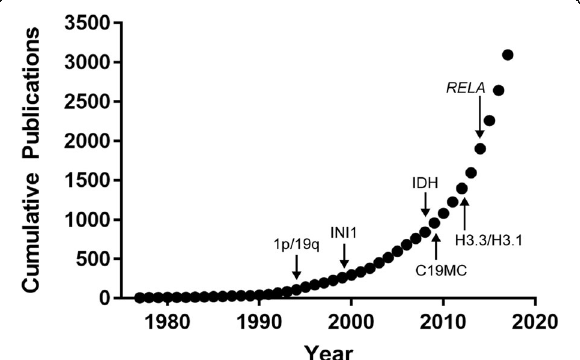
Fig. 1 Exponential growth in brain tumor molecular information. Pubmed search results for the combined terms “ brain tumor ” and “ molecular ” from 1979 to 2017. Annotations show the year of identification for key molecular features that were incorporated into the WHO 2016 diagnostic recommendations, including 1p/19q- codeletion for oligodendroglioma (1p/19q), loss of INI1 protein for atypical teratoid/rhabdoid tumor (INI1), isocitrate dehydrogenase alterations for lower grade infiltrating gliomas (IDH), histone H3 mutations for diffuse midline and other pediatric high-grade gliomas (H3.3/H3.1), RELA fusions for supratentorial ependymoma (RELA), and chromosome 19 microRNA cluster alterations for embryonal tumor with multilayered rosettes